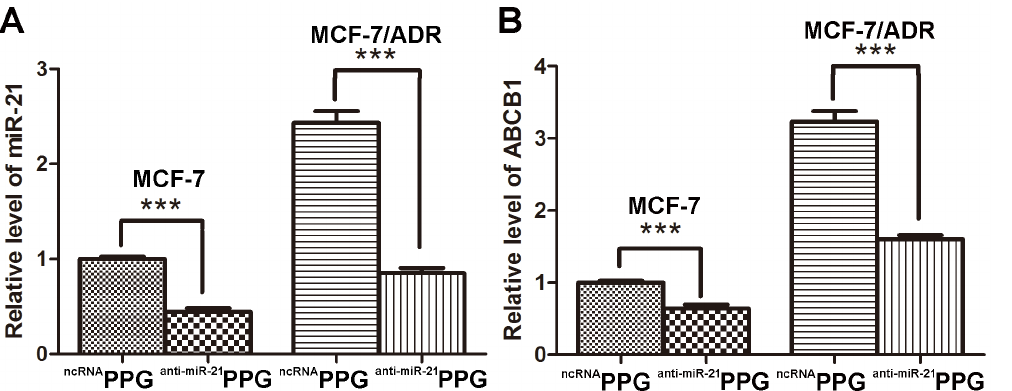
Figure 6. Invitro miR-21 and ABCB1 expression. Real time PCR analysis of relative miR-21 expression (A) and ABCB1 expression (B) in MCF-7 and MCF-7/ADR cells treated with ncRNA PPG and anti-miR-21 PPG. The expression of miR-21 and ABCB1 in MCF-7 cells treated with ncRNA PPG were arbitrarily set as 1. Data are means 6 SD for three separate experiments, ***P , 0.001.